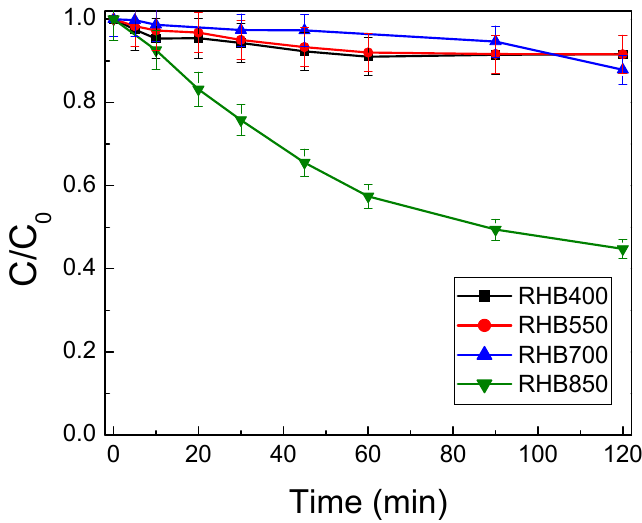
Figure 8. Adsorption of 500 µ g/L SMX onto 100 mg/L RHB samples in UPW and pH = 5.6.